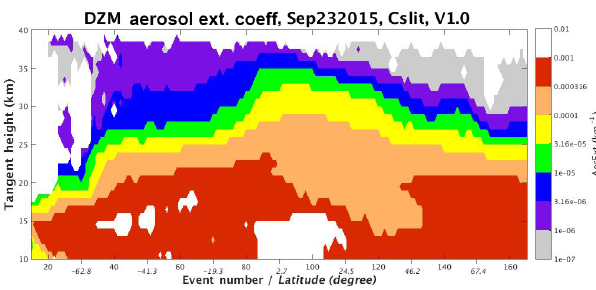
Figure 18. Daily zonal mean aerosol extinction for center slit ob- servations on 23 September 2015 (derived from the y measurements shown in Fig. 16).